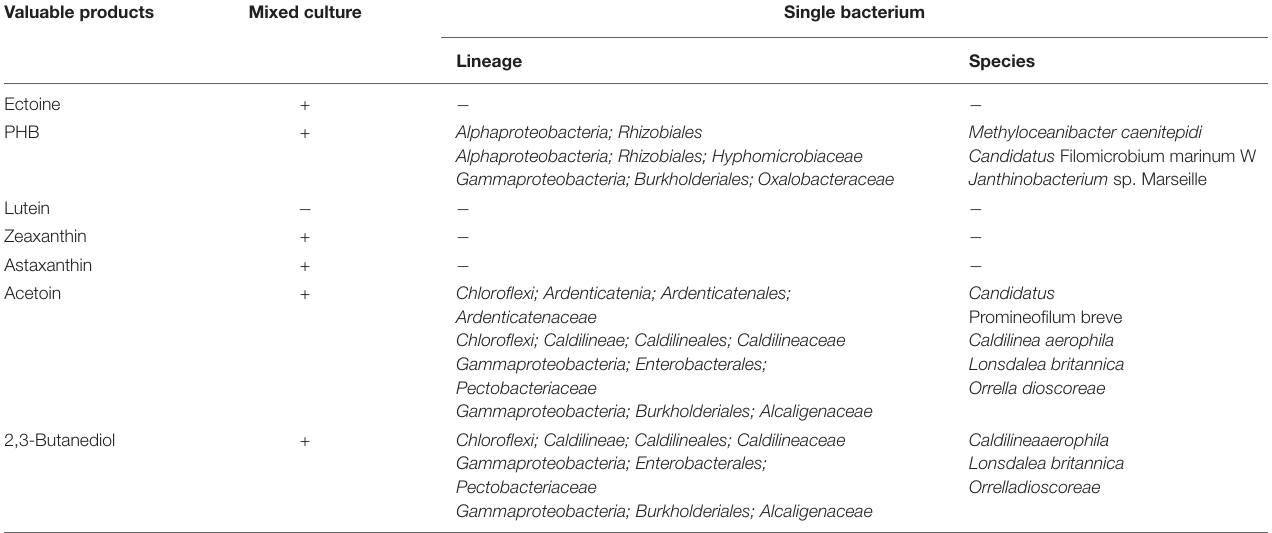
TABLE 4 | Potential for production of valuable products by mixed microbial communities and a single species of